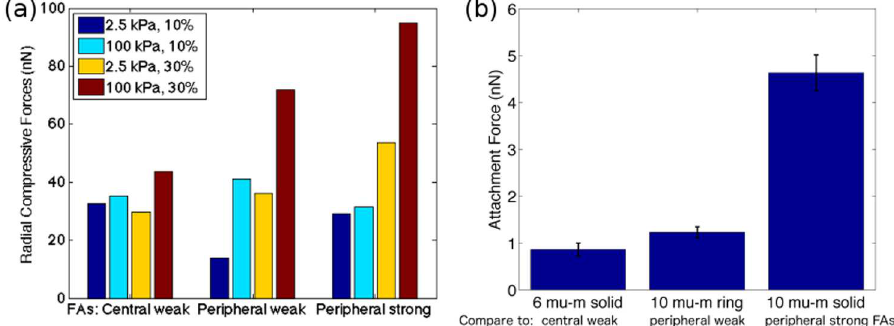
Fig 9. Comparison of computed total compressiveforces and experimentally measuredattachment forces. (a) Radial compressive forces are determinedfrom the computedradial stress data illustrated in Fig 7. Radialcompressive forces are obtained by integratingthe averagebulk stresses over the cell area and averaging over the angle 2 π . Different colors correspondto different combination of substrate Young’s modulusand critical FA-cell area ratio. (b) Attachment forces computedfrom adhesion strength data in Fig 5 in [10]. Attachment forces were computedby multiplyingexperimentally measuredattachment strengths by total attachment area. Attachment strengths were determinedby counting remaining numbersof adherent cells at the end of a spinningplatform experiment. Three attachment configurations were considered:A 6 μ m circularpatch with a total adhesivearea of 28 μ m 2 , a 10 μ m ring with a total adhesivearea of 28 μ m 2 , and a 10 μ m circle with total adhesivearea of 78 μ m 2 . Each spinningplatform experiment was performed in triplicate. Attachment forces computed from averageattachment strengths and corresponding standard deviations are illustrated. More detailscan be found in [10]. Experiments confirm that as total attachment area increasesand as attachments form closer to the periphery,attachmentforces